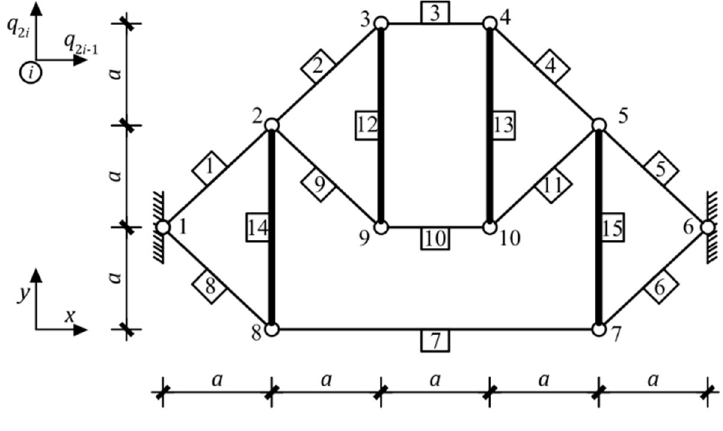
Figure 6. Second pure tensegrity truss.